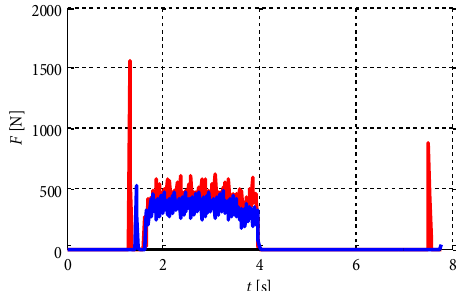
Fig. 11. Roll–rack edge contact forces for left rear quarter of the vehicle (simulation result)